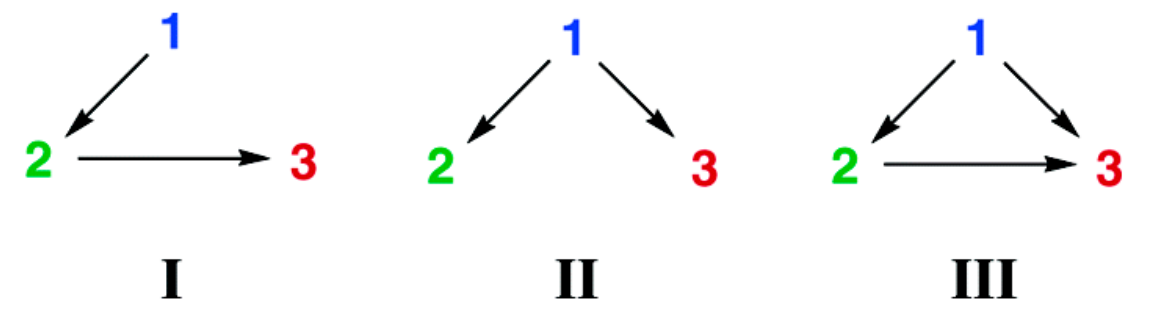
Figure 43. Schematics of three energy transfer schemes [165].